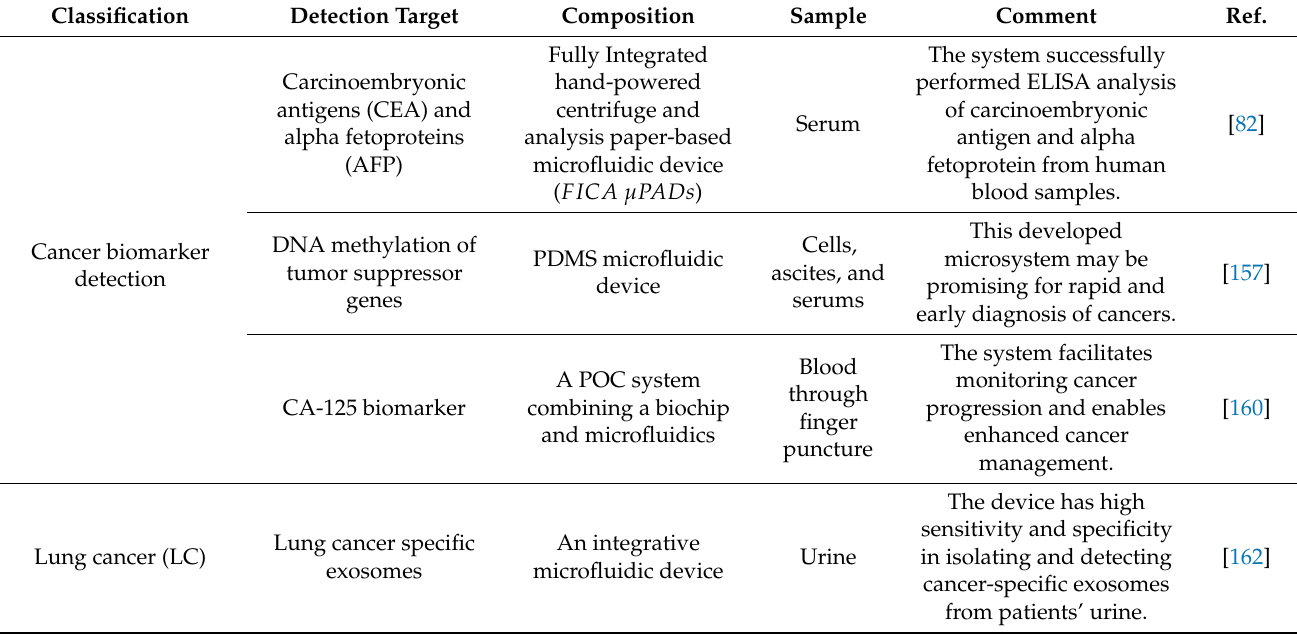
Table 5. The overview of applications of microfluidic POC devices in the early diagnosis of tumors (cancer). Detection Target Composition Sample